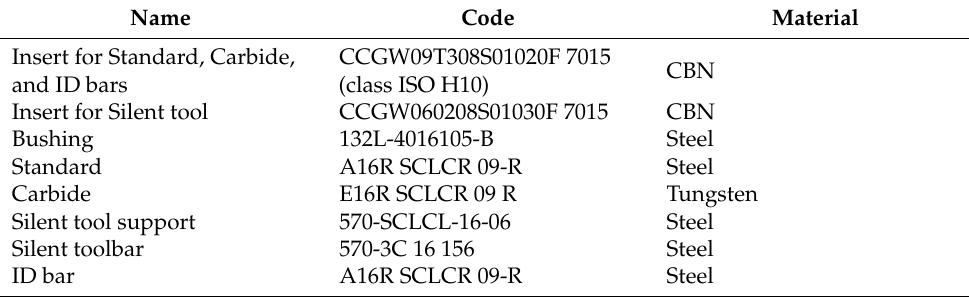
Table 1. Main data of the tools with a constant diameter of 16